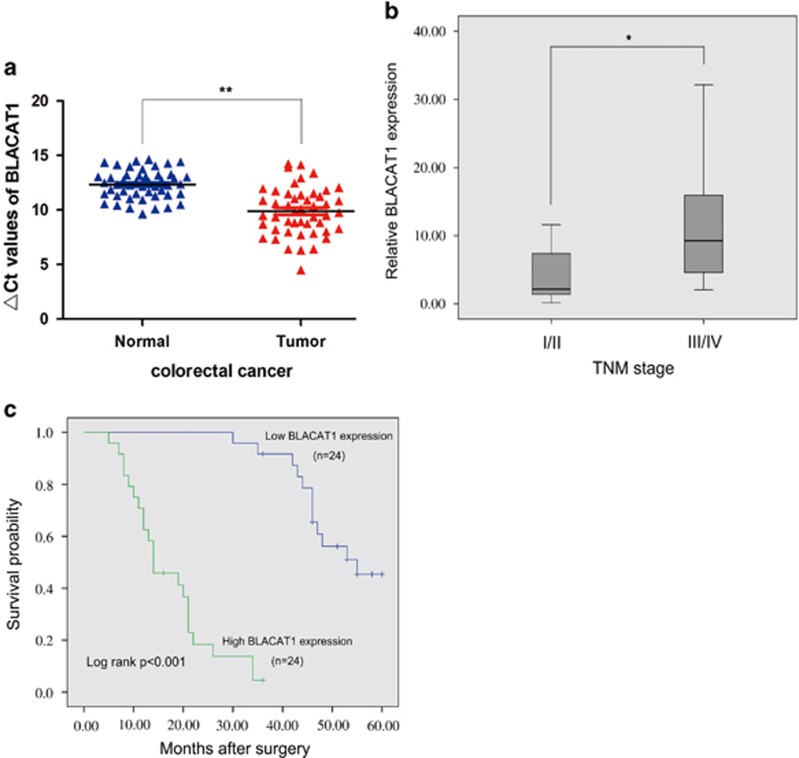
Expression of BLACAT1 in CRC tissues and its clinical parameters. (a) Relative expression of BLACAT1 in CRC tissues (N=48) campared with the corresponding non-tissues (N=48). BLACAT1 expression was examined using quantitative real-time PCR(qRT-PCR) and normalized to GAPDH expression. The ΔCt value was determined by subtracting the GAPDH Ct value from the BLACAT1 Ct value. Smaller ΔCt value indicates higher expression. (b) Higher BLACAT1 was positively correlated with TNM stage. (c) Patients with high levels of BLACAT1 expression showed reduced survival times compared with patients with low levels of BLACAT1. *P<0.05, **P<0.01